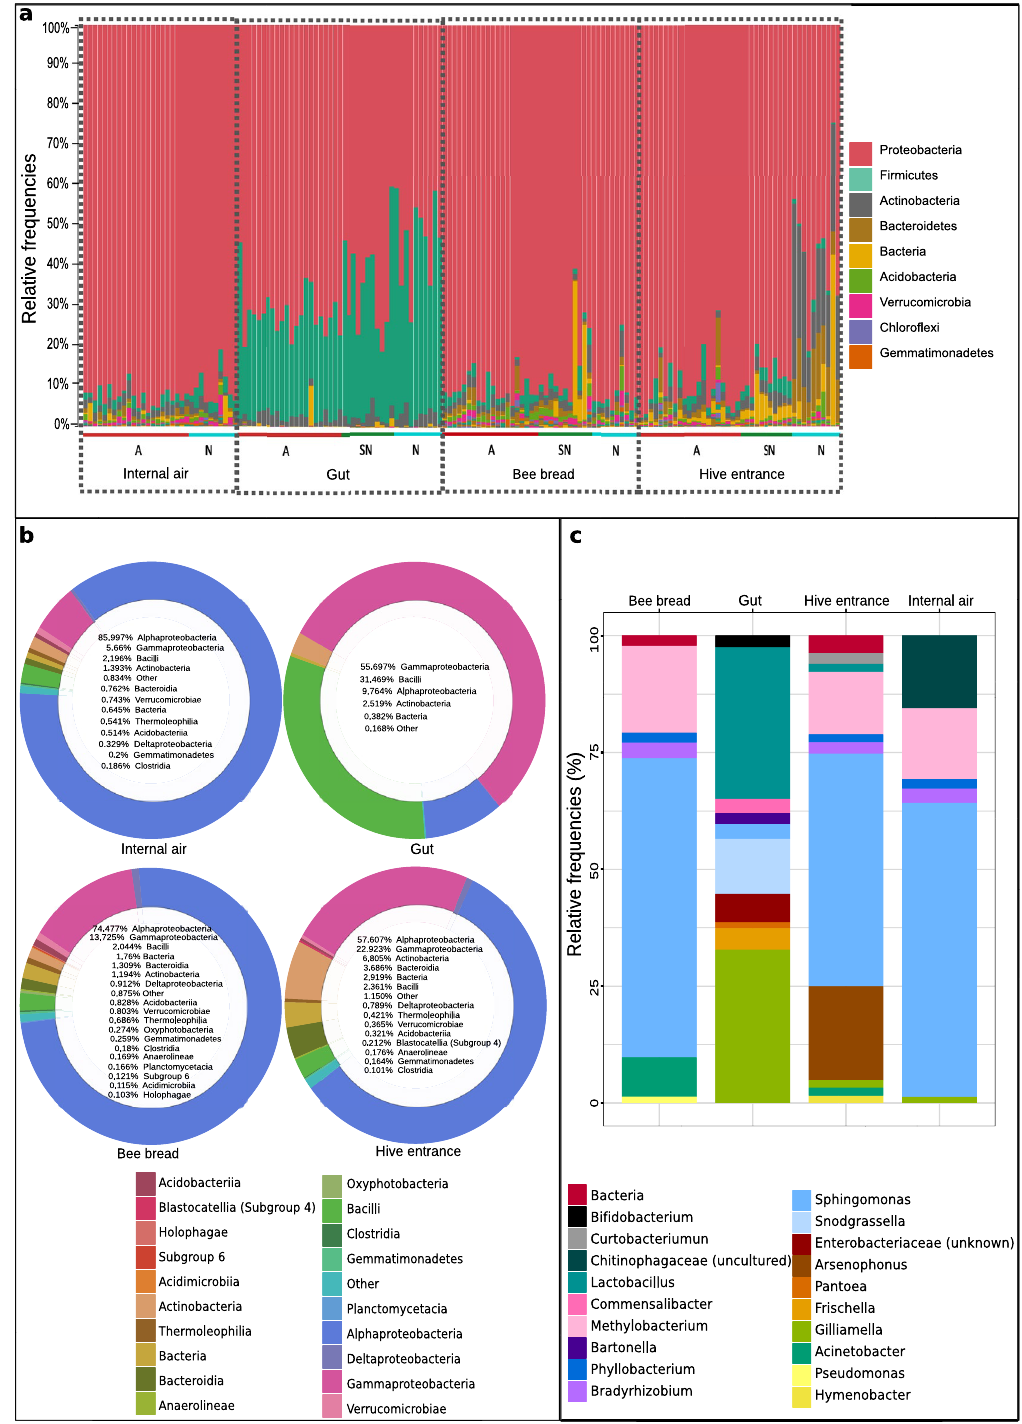
Figure 2. Bacterial communities of the studied hive niches at class and phylum levels. ( a ) Bar plots of the relative frequencies of the bacterial phyla present in each hive niche. Proteobacteria were the most abundant, excluding some natural and semi-natural gut samples rich in Firmicutes, as well as several natural hive entrances enriched for Actinobacteria and Bacteroidetes (A = agricultural apiary, SN = semi-natural apiary, N = natural apiary). ( b ) Pie charts of the bacterial classes presenting relative abundances ≥ 0.1%, in percentages. Some ASVs were only classified up to Domain level, and grouped as “Bacteria”. The group “Others” includes all additional taxa. Gut samples displayed a distinct microbial profile. Internal air, bee bread and hive entrance had similar abundances, with enrichment of Alphaproteobacteria, Actinobacteria and Bacteroidia; and numerous bacteria less than 0.1% abundant. ( c ) Most abundant bacterial genera (≥ 1.0%) per sample type, in percentages. Internal air was not sampled in the semi-natural apiary due to methodological